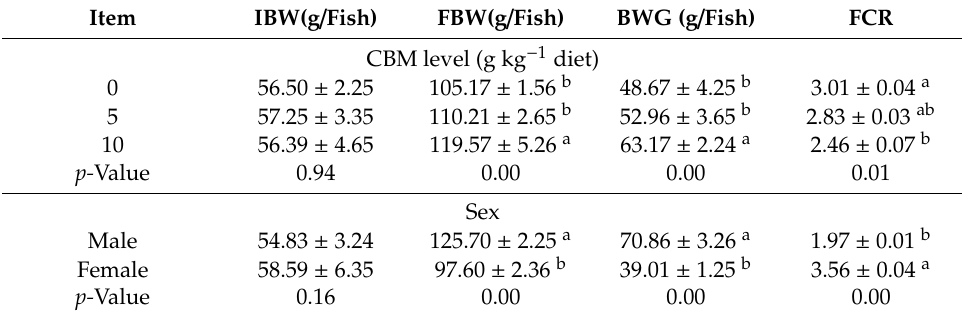
Table 2. E ff ect of dietary supplementation of cacao bean meal (CBM) on the growth performance of broodstock C. auratus